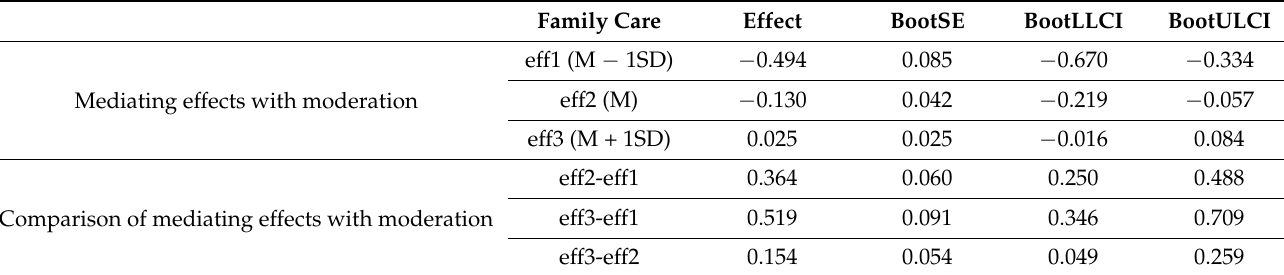
Table 7. Direct and mediating effects at different levels of family care.